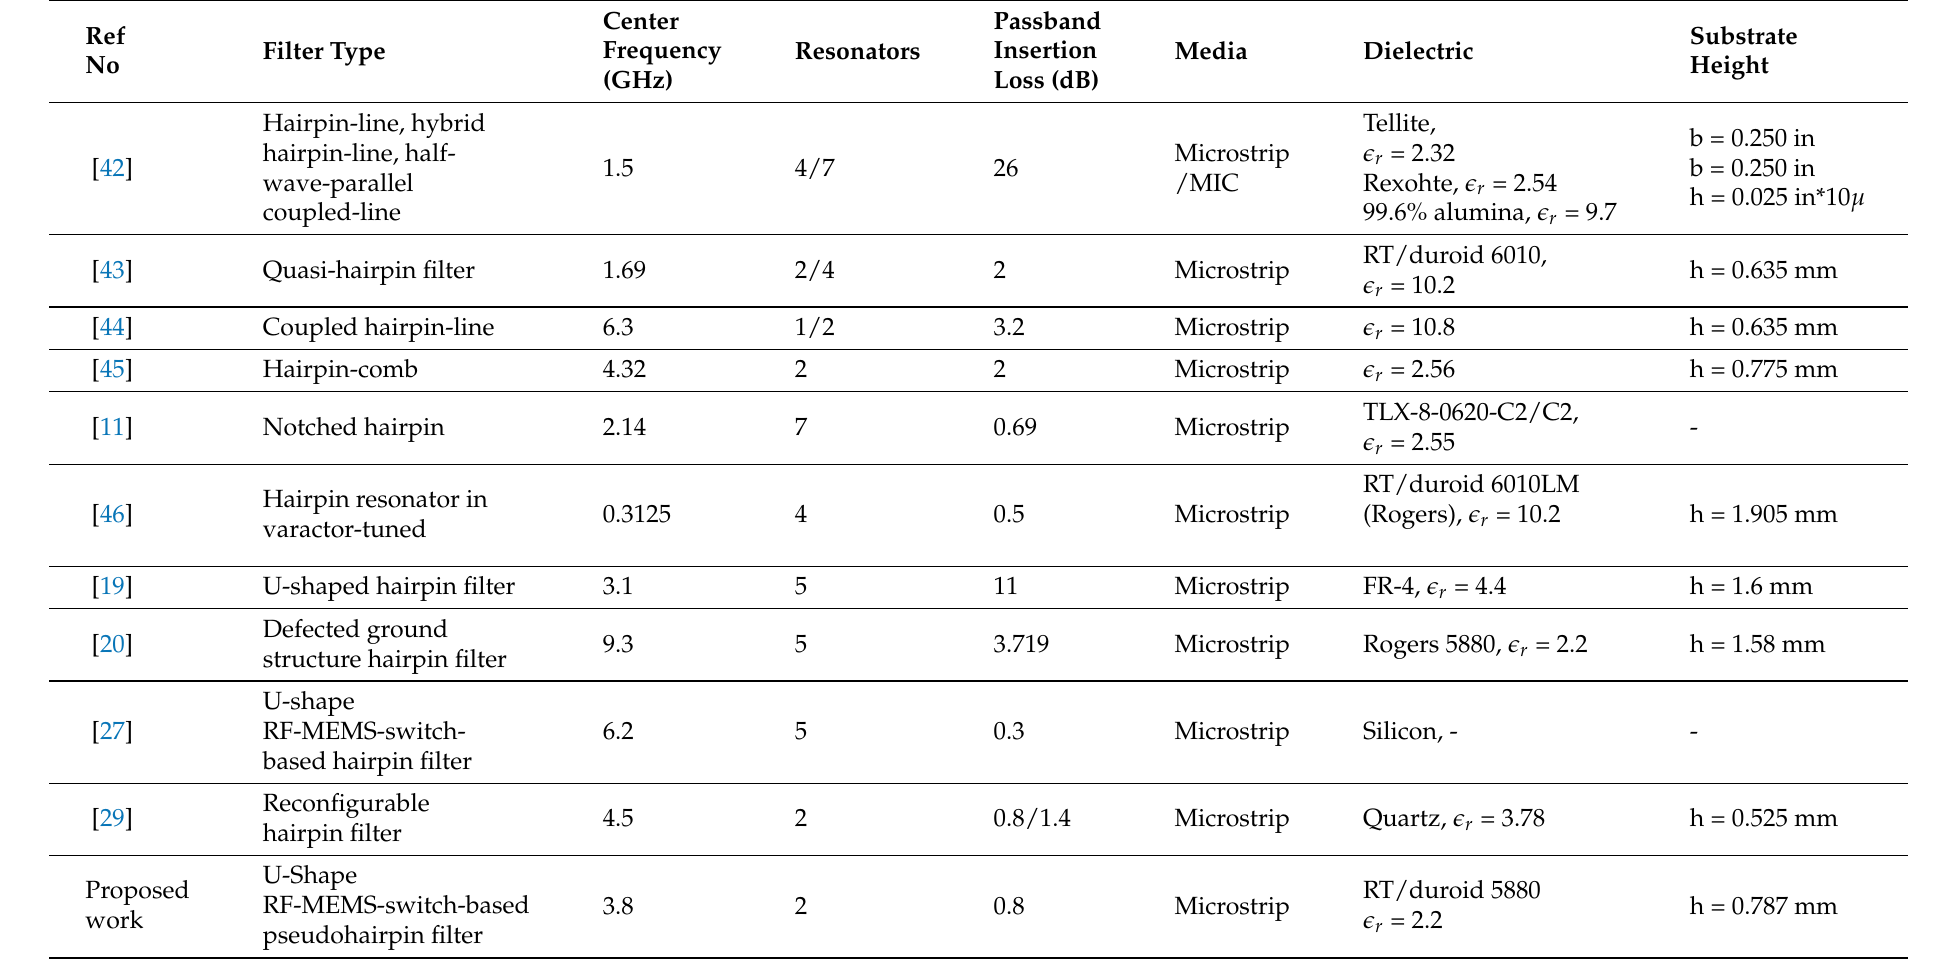
Table 1. Comparison with other hairpin